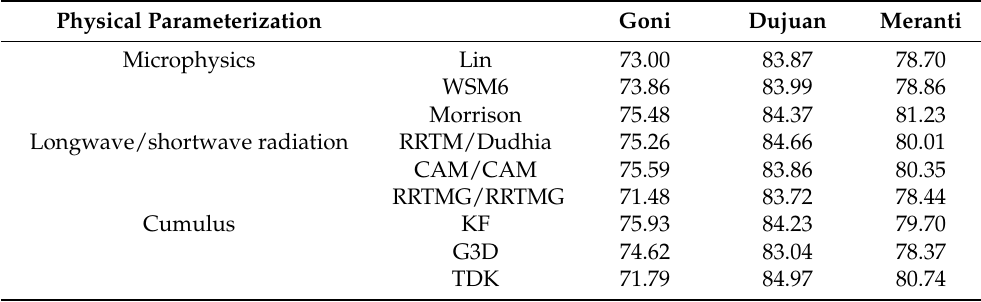
Table 8. Mean skill score of the single physical parameterization in the wind speed